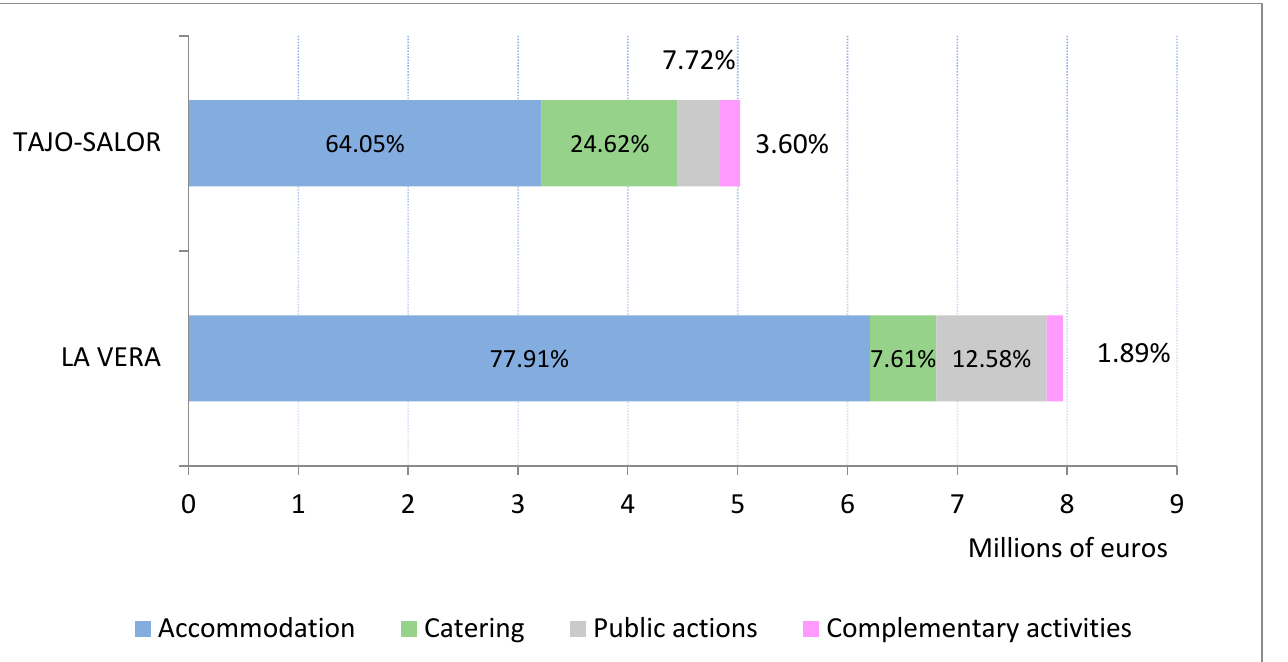
Figure 3. Distribution of tourism investment in the regions of Tajo-Salor and La Vera, Source: Own elaboration.